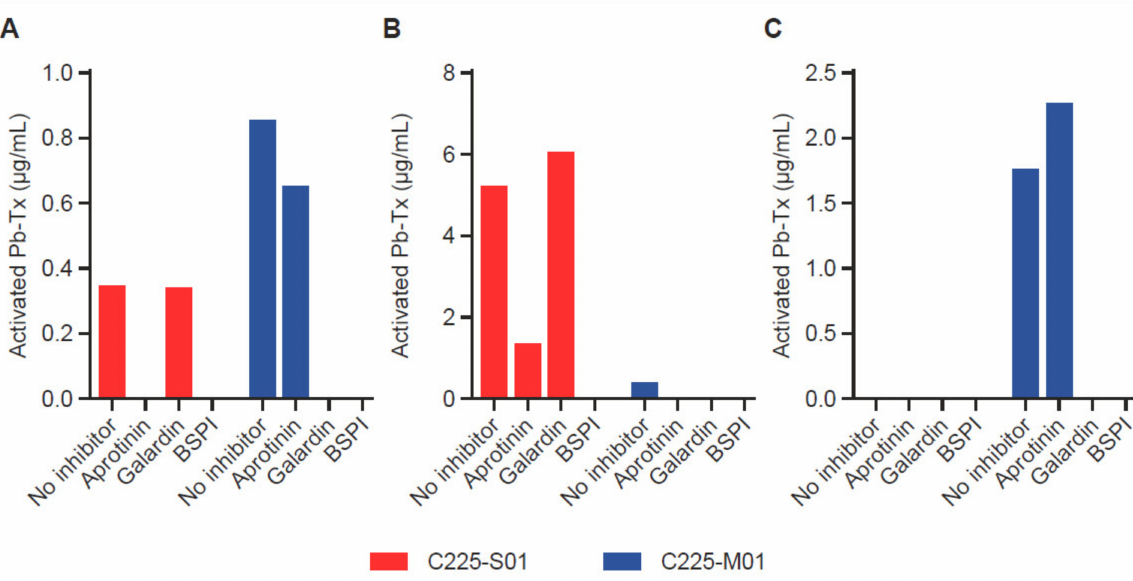
Figure 4. Validation of the quantitative zymography (QZ) assay for different protease specificities in human tumor tissue. Serine protease and matrix metalloproteinase (MMP) activity were measured with 20 µ g/mL Probody therapeutics (Pb- Tx) C225-S01 and C225-M01, respectively, after incubation for 48 h at 37 ◦ C with tissue sections. Protease activity was characterized in cryopreserved sections of ( A ) head and neck squamous cell carcinoma, ( B ) pancreatic cancer, and ( C ) prostate cancer in the presence of the following protease inhibitors: serine protease inhibitor aprotinin, MMP protease inhibitor Galardin, and a broad-spectrum protease inhibitor cocktail